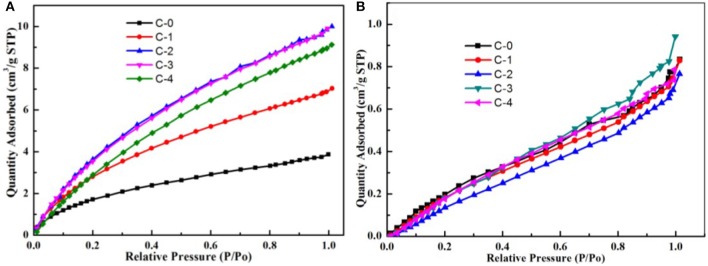
(a) N2 adsorption of the simulated static experiments at 298 K; (b) CH4 adsorption of the simulated static experiments at 298 K.